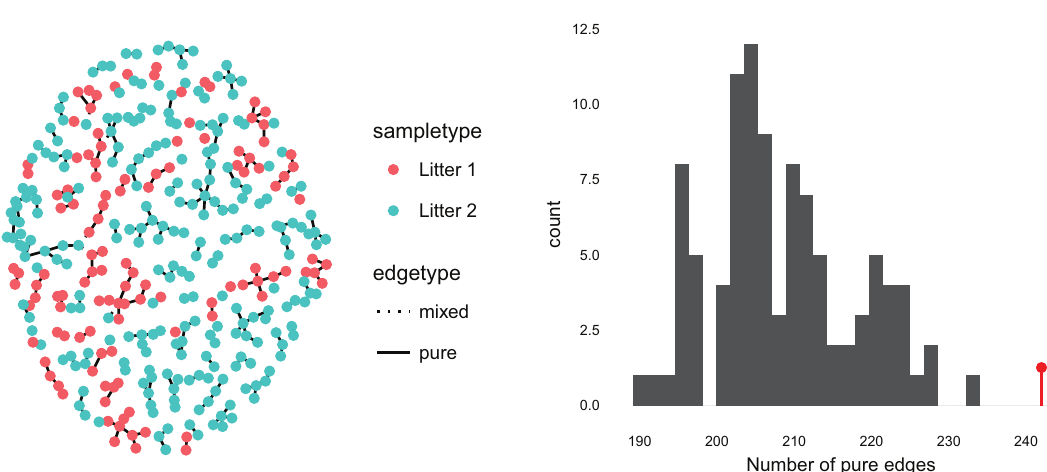
Figure 24. The graph and permutation histogram obtained from a nearest-neighbor graph with Jaccard